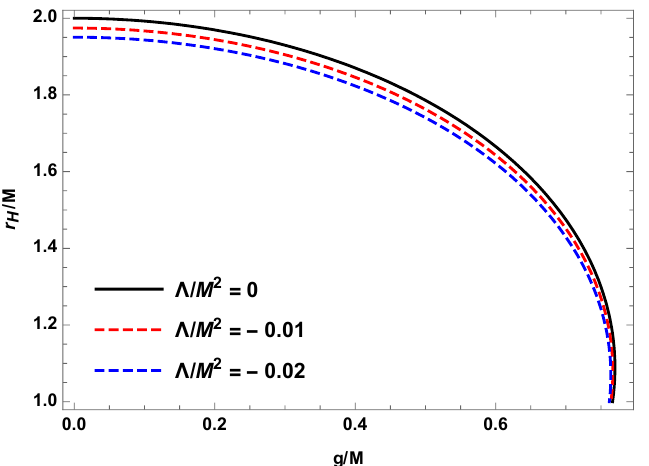
Figure 1. The dependence of the event horizon radius on the parameters g and Λ